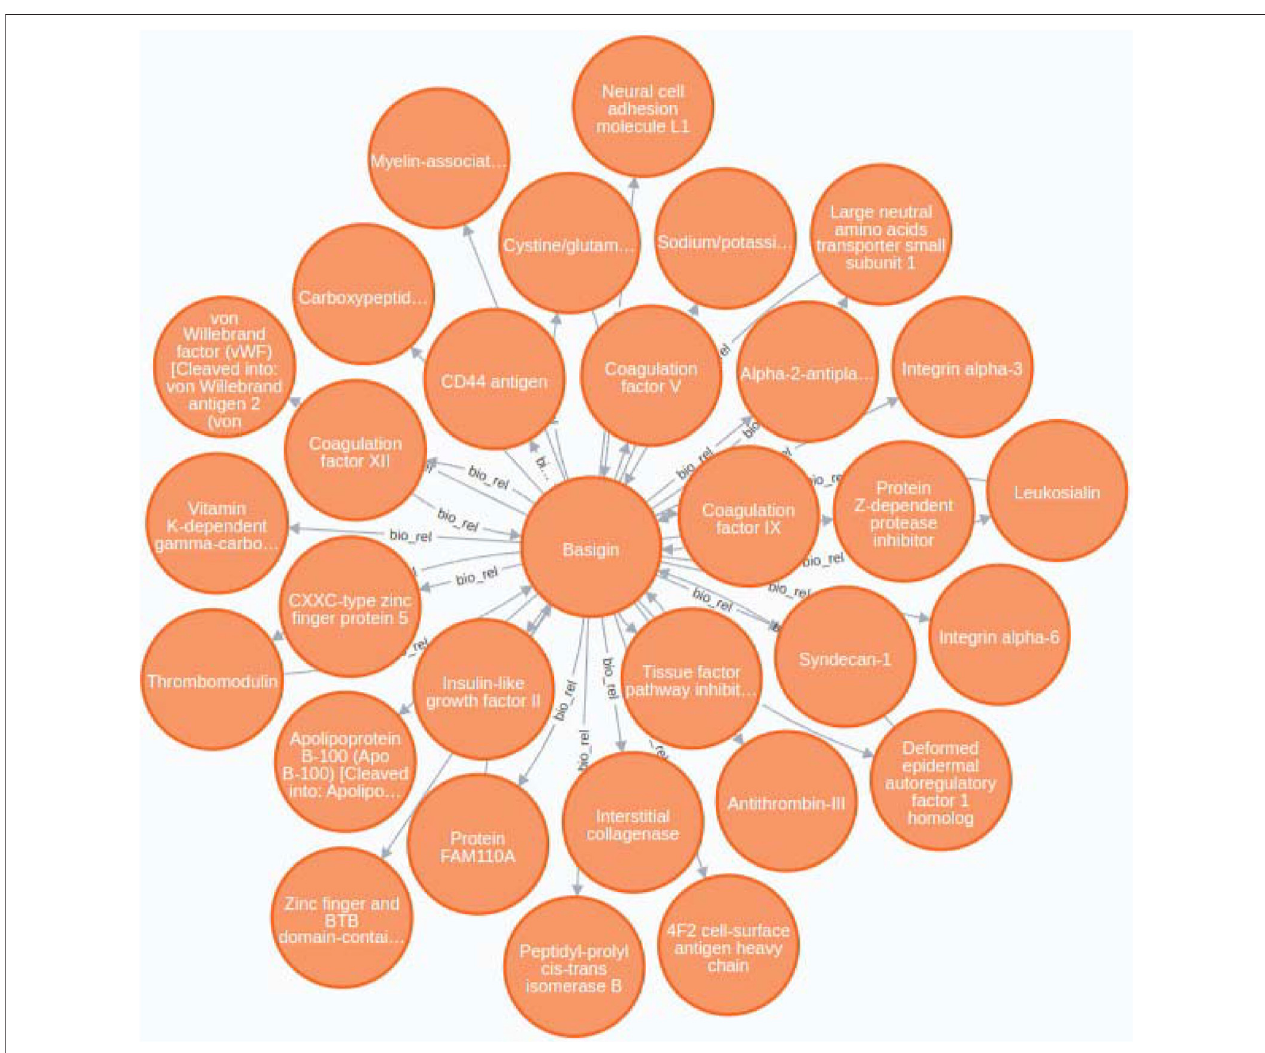
FIGURE 8 | Basigin-Proteins interaction network. It has been created using the Neo4j user interface. In addition a limit of 30 nodes has been set. BioTagme and STRING edges have been merged in a single one.